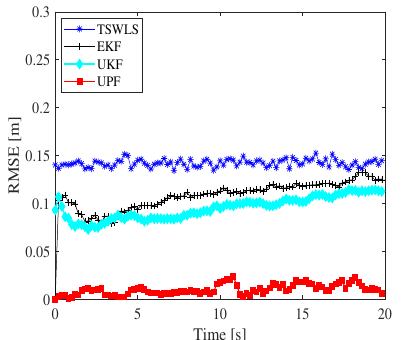
= 0.5 ◦ , σ = 0.1 d i i